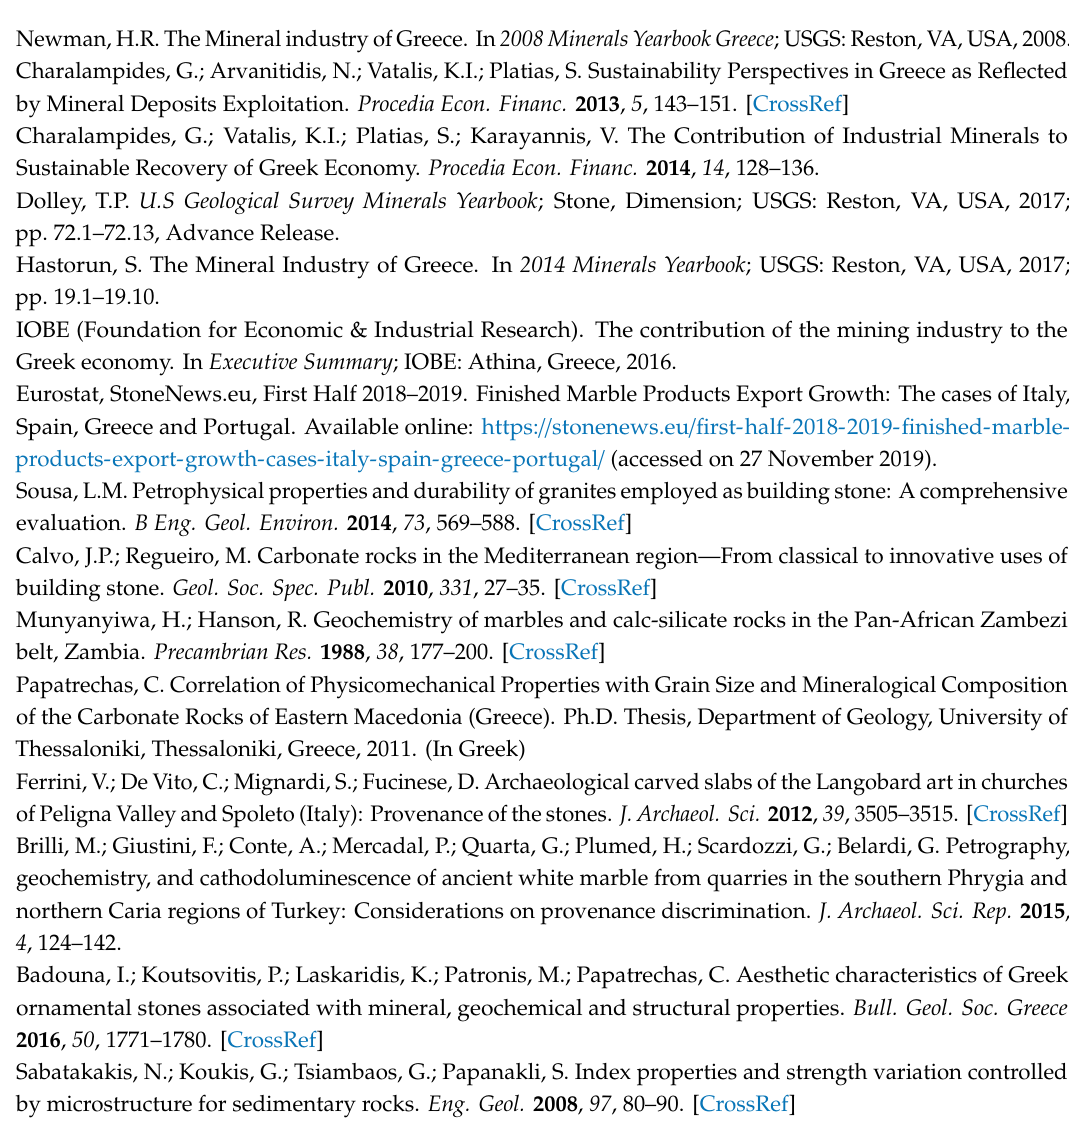
Table S1: Whole rock major elements (wt.%) and trace elements (ppm) compositions of carbonate ornamental stones from selected regions in Greece, Table S2: Physico-mechanical properties of the ornamental stone samples from selected regions in Greece. The testing methods were conducted according to EN